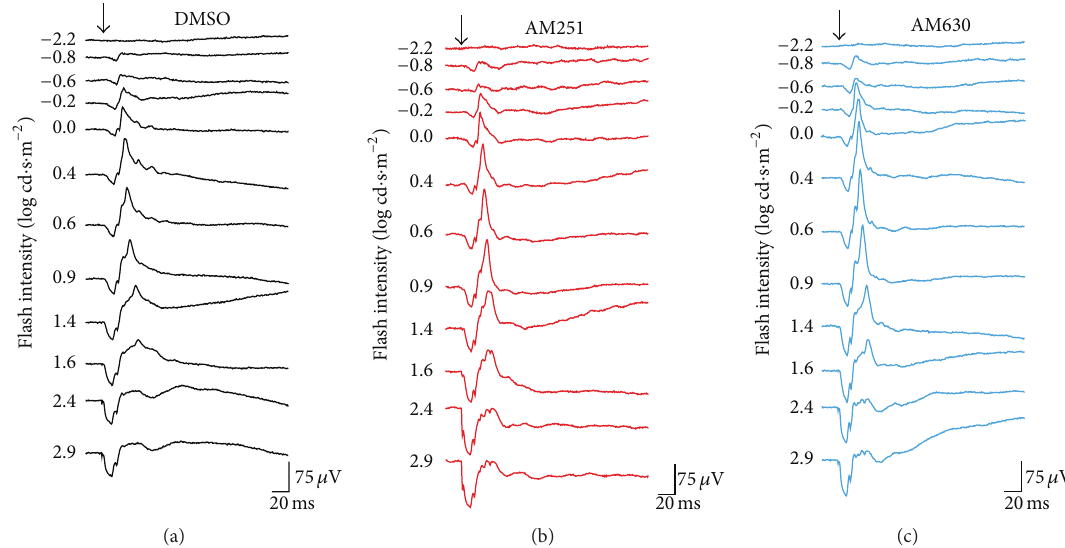
Figure 2: Raw photopic ERGs in the different drug injection groups. Representative ERGs recorded after intravitreal injection of DMSO (a), AM251 (b), or AM630 (c). ERG recordings of each treated animal were established by presenting progressively brighter flashes (top to bottom). Horizontal calibration, 20 ms; vertical calibration, 75 𝜇